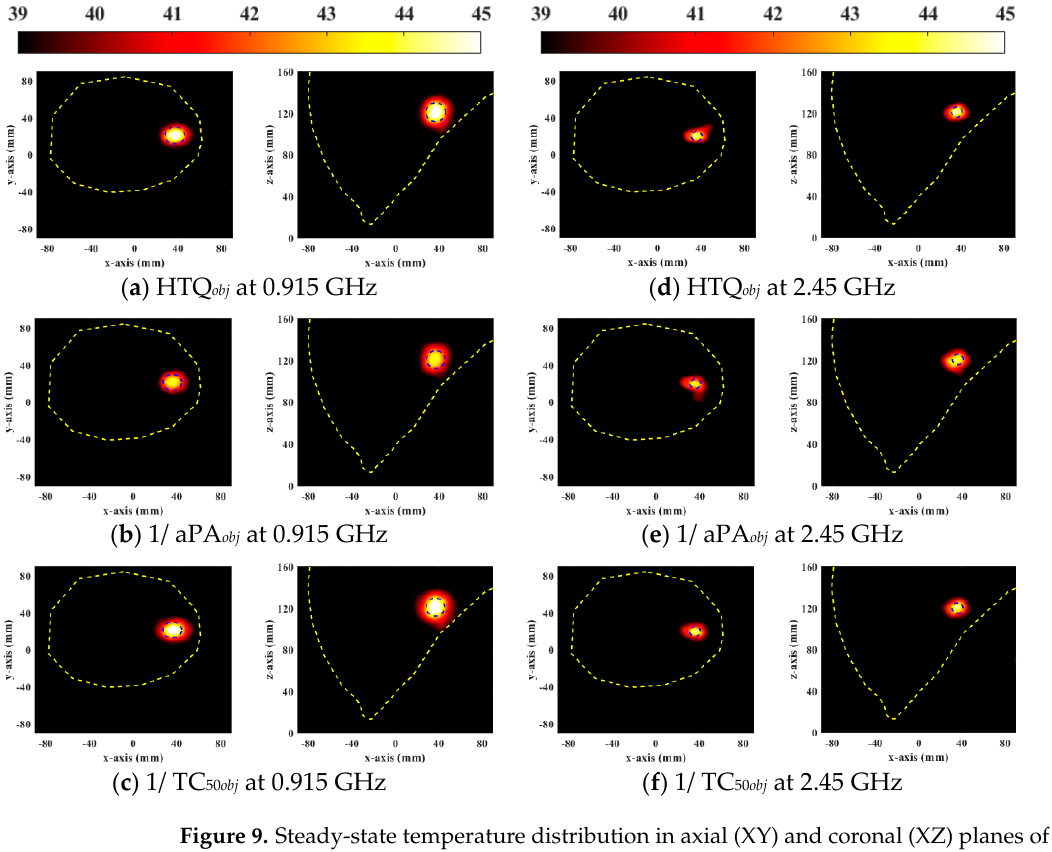
Figure 9. Steady-state temperature distribution in axial (XY) and coronal (XZ) planes of a heteroge- neous breast model optimized by each objective function used in DE.